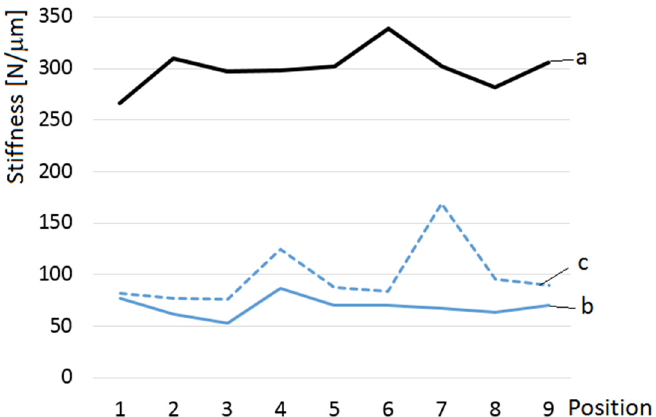
Figure 12. Comparison of the degree of (a) static stiffness; (b) Experiment 3—Static Stiffness after Sliding (SSaS) in +X direction; (c) Experiment 3—SSaS stiffness in the X-direction (force F a ).